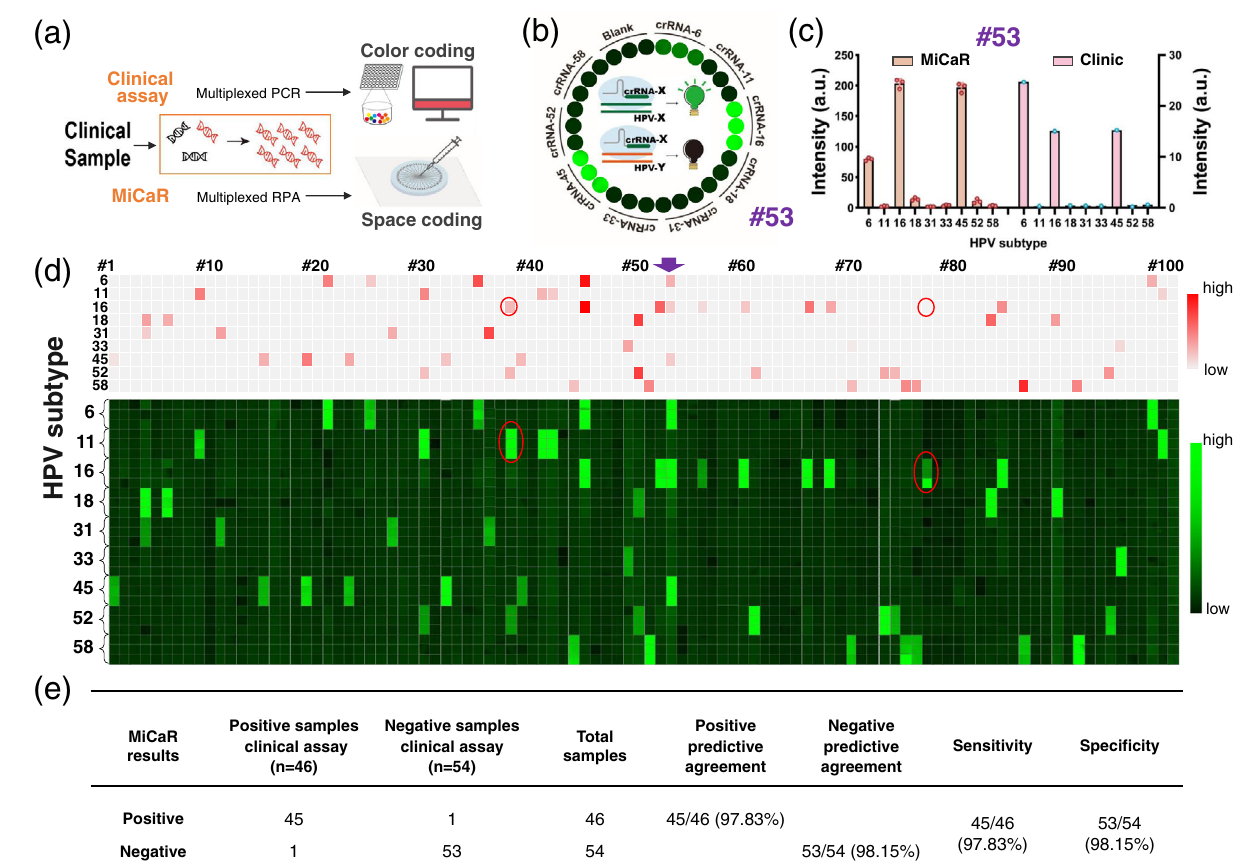
Fig. 6 | Testing results of 100 patient samples for HPV infection. a Brief sche- matic showing the differences between MiCaR and the clinical assay. The clinical laboratory conducting HPV subtyping assays using multiplexed PCR for target ampli fi cation and color coding for detection readouts. Meanwhile, in MiCaR, multiplex RPA was used for ampli fi cation, and microchip-based space coding was used for detection readouts. b Testing results of Sample #53, which was triple- positive for HPV subtypes, presented as a circle showing the original fl uorescence images of the 30 outlet wells. c Quantitative analysis of results for Sample #53, testedusingMiCaRandtheclinicalassay.Valuesrepresentthemean±SDand n =3